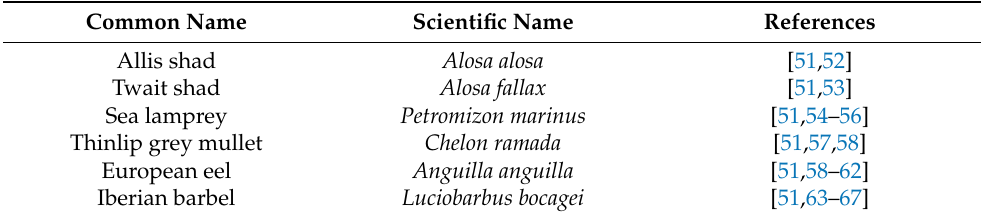
Table 1. Literature considered for the construction of the species habitat suitability curves (HSC), based on key variables that structure fish passability at low-head ramped weirs [45]: flow velocity at the ramp weir and water depth above the